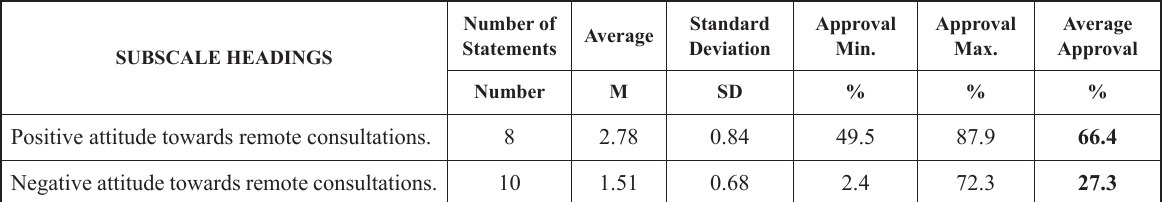
Table 5. Generalized Descriptive Statistical Data on Positive and Negative Rating of Remote Consultations by Patients with Chronic